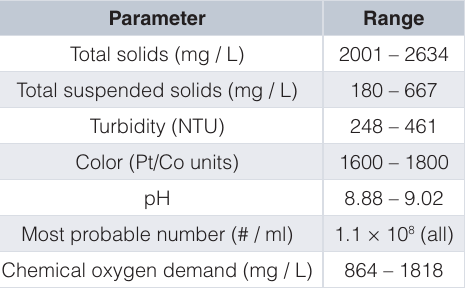
Table 1. Characteristics of untreated